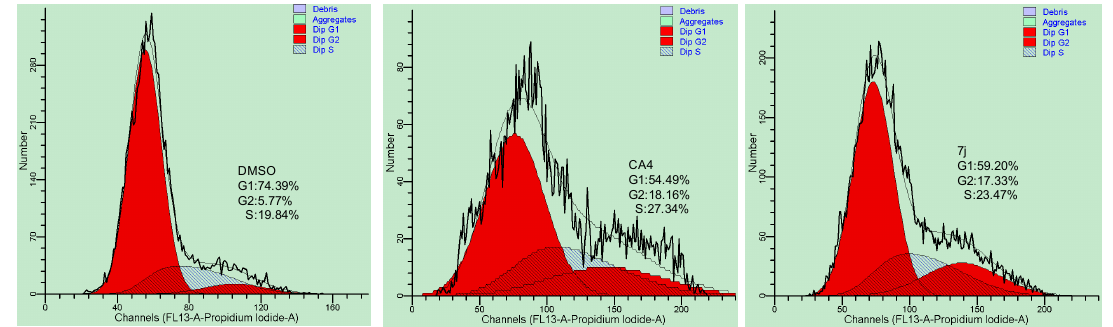
Figure 3. MDA-MB-231 cell cycle distribution of CA4 (1 µM) and 7j (1 µM).